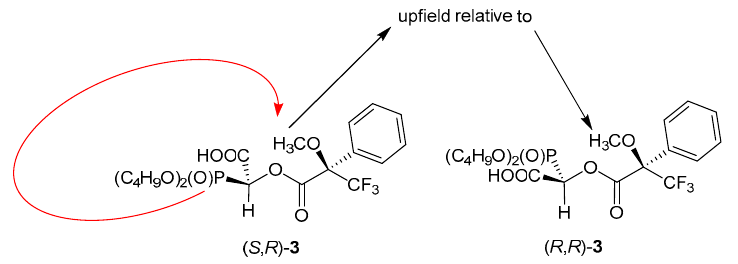
Figure 4. Anisotropic effect of P=O group on hydrogen atoms of methoxy groups.